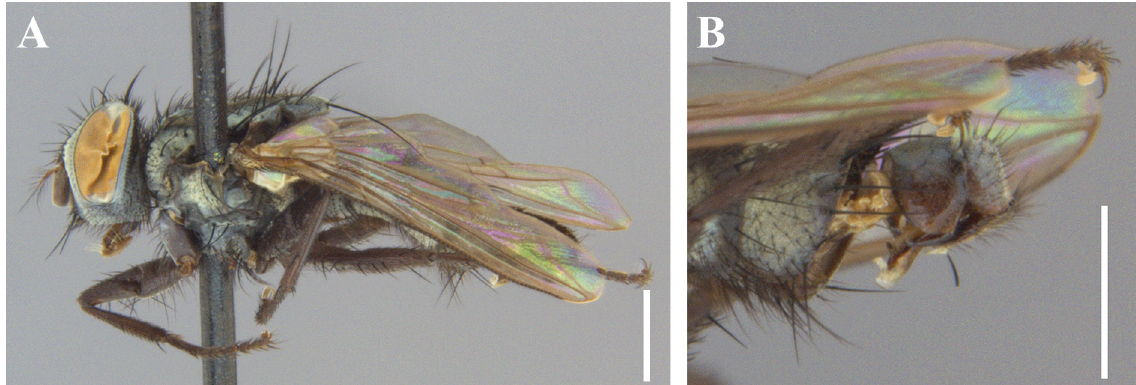
Fig. 13. Dexosarcophaga pallida sp. nov., ♂, paratype (NHRS [lost]), Colombia, Caquetá, Chiribiquete National Park. A. Habitus, lateral view. B. Terminalia, lateral